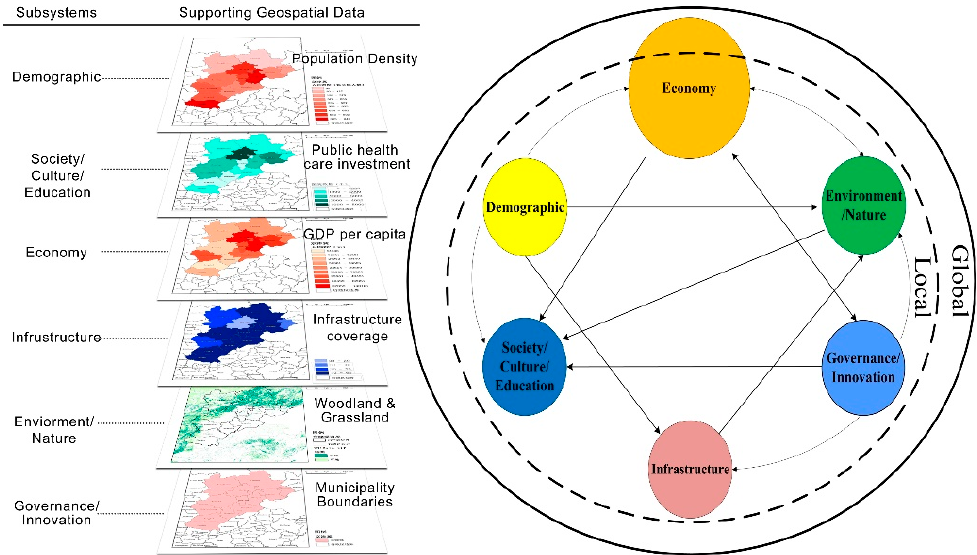
Figure 5. Illustration of six types of subsystems of the urbanization and eco-environment system. Source: Drawn by authors.